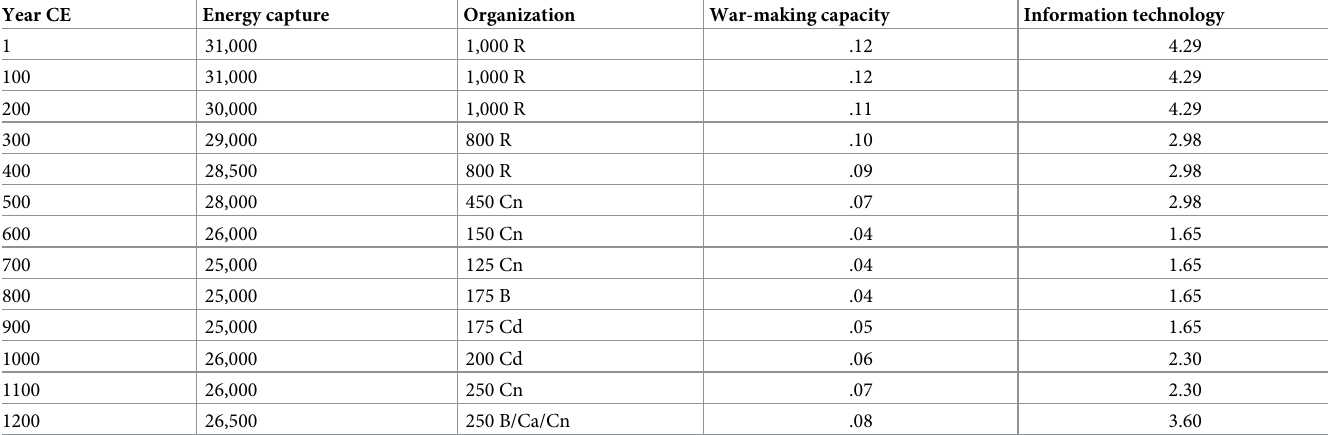
Table 5. Four indices of social development in the